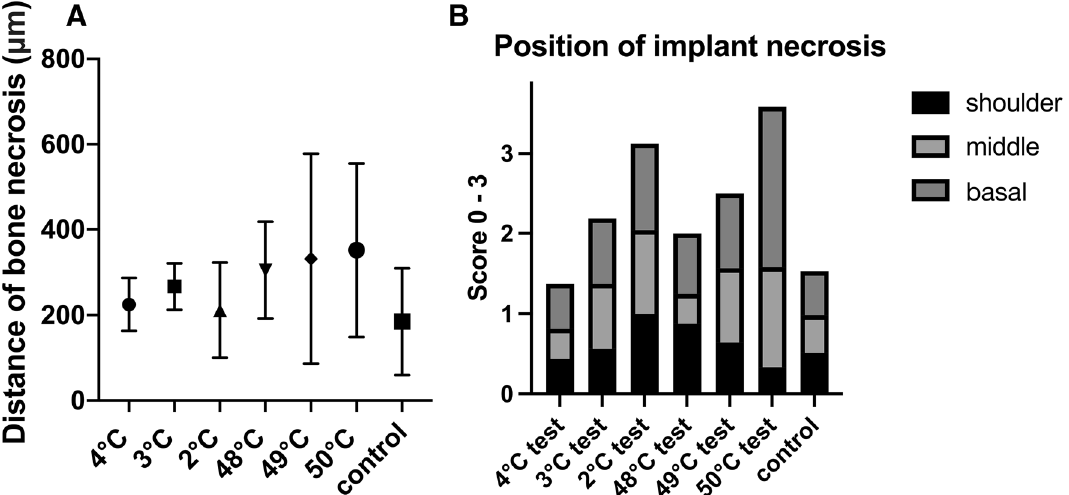
Figure 4. ( A ) Bone necrosis was measured at the maximum distance in a 90° angle to the implant surface in μm. ( B ) Additionally, the frequency distribution of necrosis sites at the implant shoulder, middle or tip were